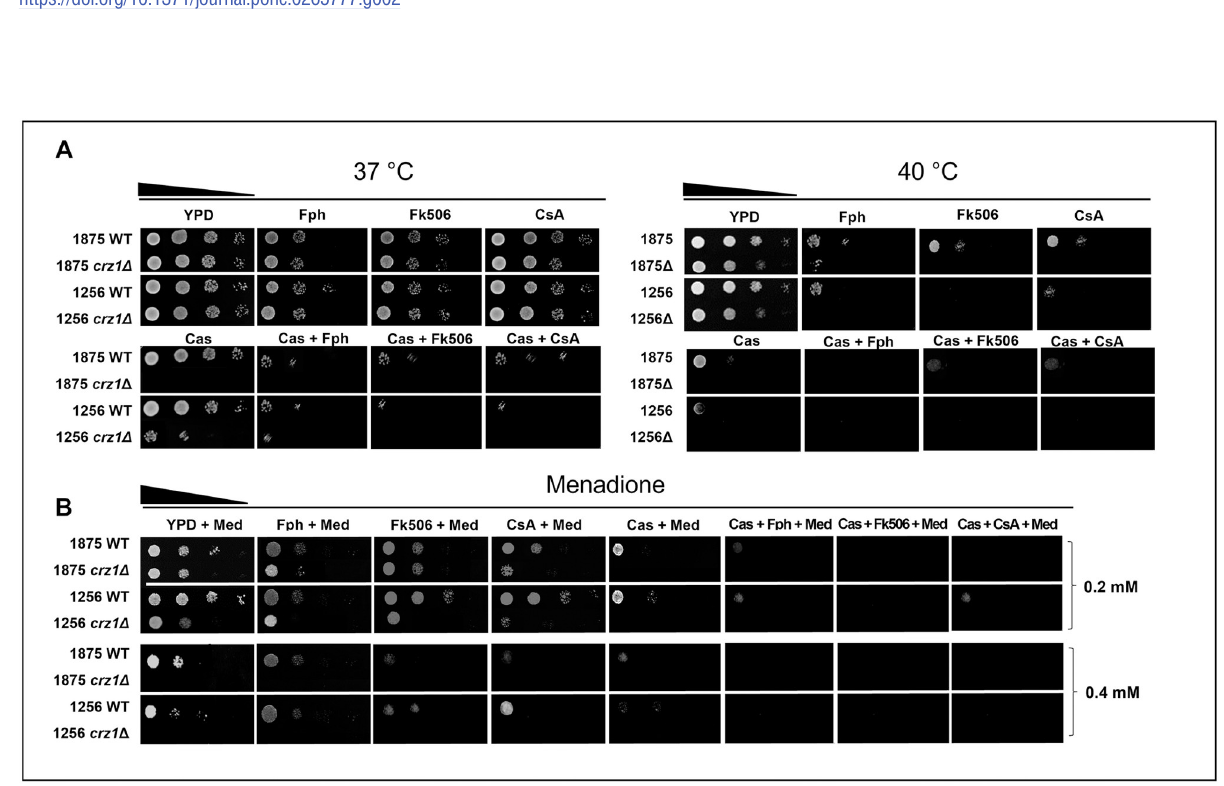
Fig 3. Stress responses. (A) Isolates were heat-shocked at 37 and 40˚C with 15 μ g/mL CaM/CaL inhibitors (fluphenazine (Fph), tacrolimus (Fk506), cyclosporin A (CsA)) and with or without 1 μ g/mL caspofungin (Cas) (B) and were tested for oxidative stress with 0.2 and 0.4 mM menadione with or without CaM/CaL